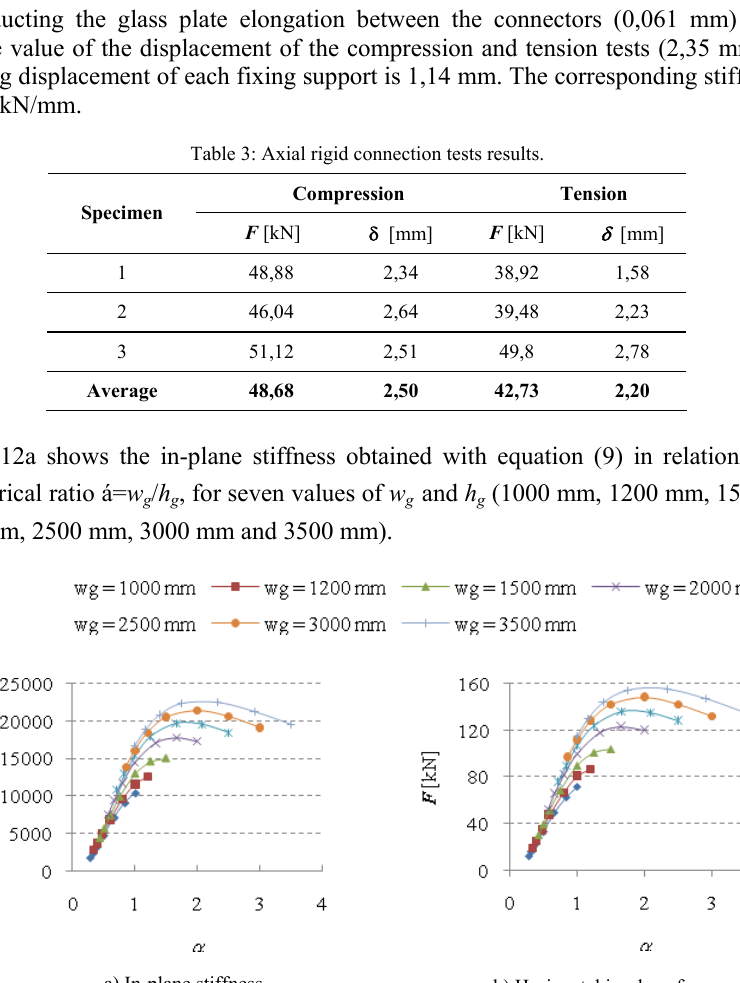
Figure 12: Parameter